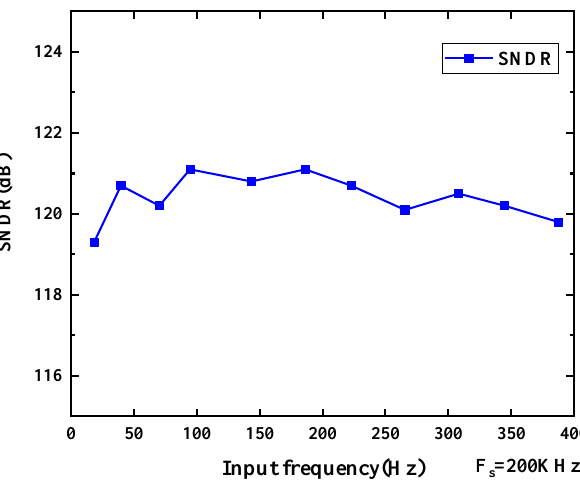
Figure 15. SNDR versus input signal frequency at − 1.1 dBFS input